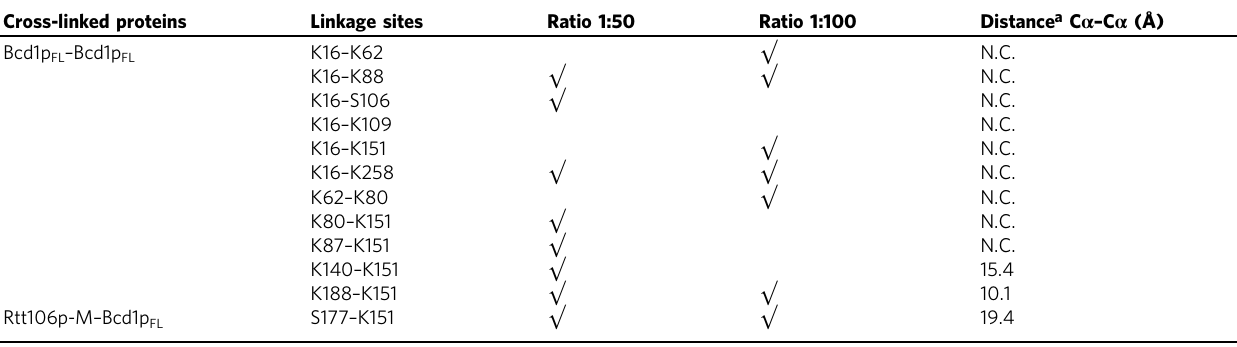
Table 3 Cross-linked sites observed with different protein:BS3 (d0/d4) ratios for the complex Bcd1p FL :Rtt106p-M. Cross-linked proteins Linkage